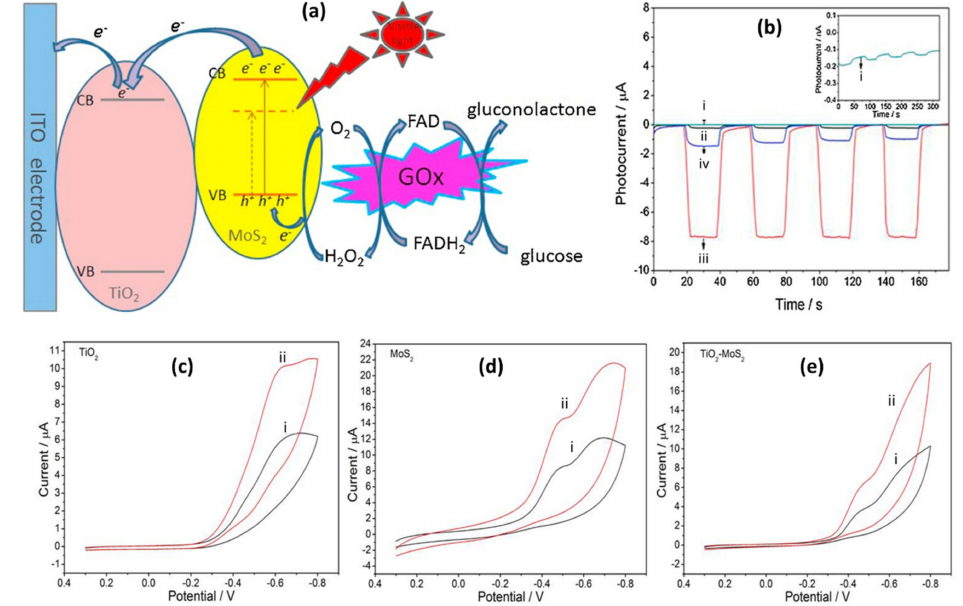
Figure 12. ( a ) Schematic representation of MoS 2 -TiO 2 -GOx|ITO PEC biosensor, the energy diagram and the proposed charge transfer mechanism. ( b ) Photocurrent response of (i) Pure MoS 2 |ITO, (ii) TiO 2 nanorods|ITO, (iii) MoS 2 -TiO 2 |ITO, (iv) MoS 2 -TiO 2 -GOx|ITO in PBS solution (pH 7.4). CV of ( c ) TiO 2 -GOx, ( d ) MoS 2 -Gox, and ( e ) MoS 2 -TiO 2 -GOx (i) without and (ii) with illumination in PBS solution containing 2 mM glucose [106]. Figures reproduced with permission from Ref. [106], copyright © 2017 Published by Elsevier,